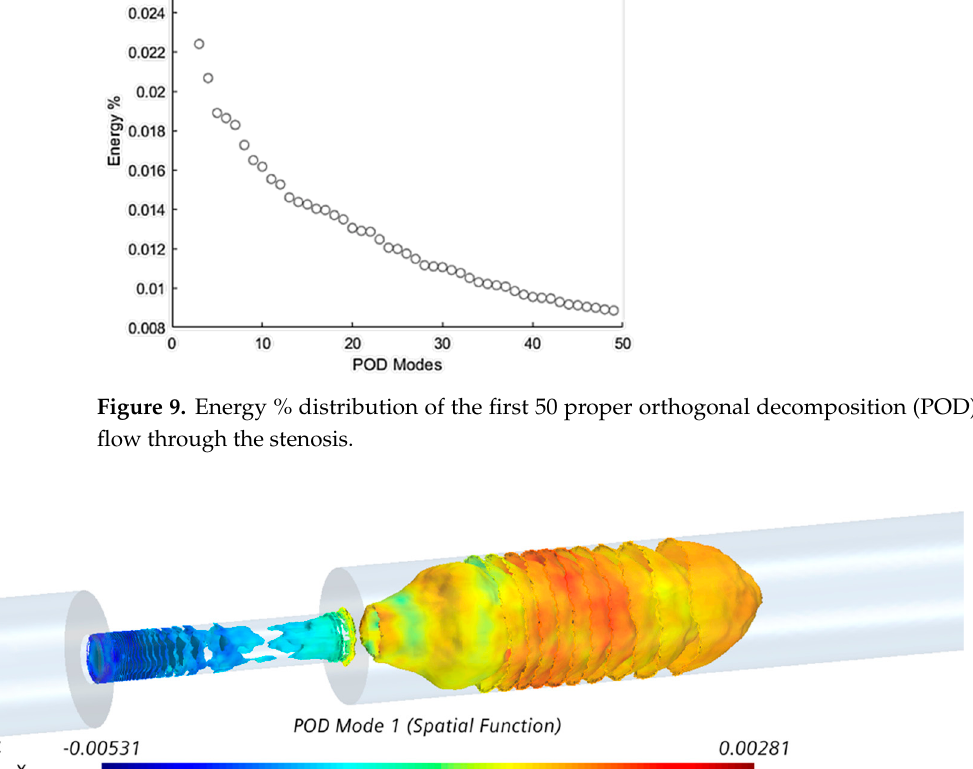
flow through the stenosis.